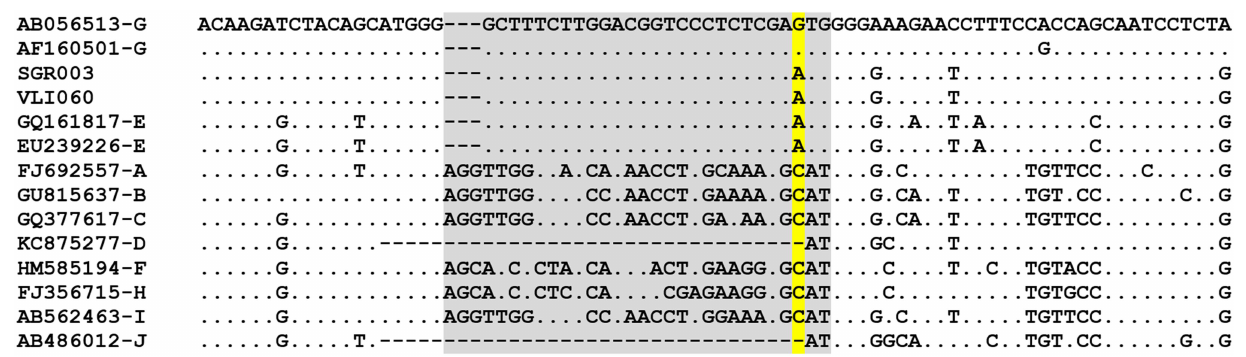
FIGURE 2 | Comparison of partial pre-S1 sequences from HBV/A to HBV/J and two ancient DNA sequences related to HBV/G (SGR003 and VLI060, published in Kocher et al., 2021). Region where HBV/E and HBV/G share a unique sequence (shaded in gray). Nucleotide site where HBV/G differs from its ancestral sequences and HBV/E (shaded in yellow). HBV reference sequences based on McNaughton et al.